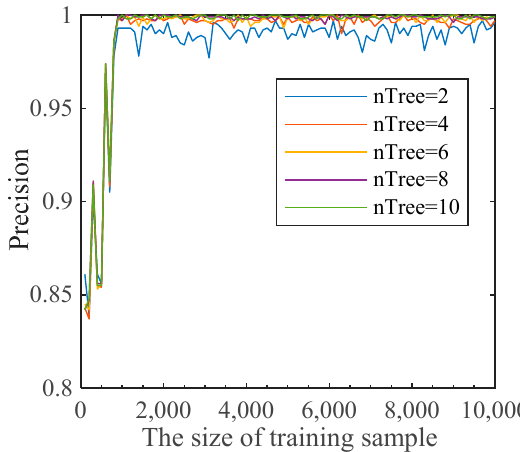
Figure 4. Simulation of nTree and the size of training sample.